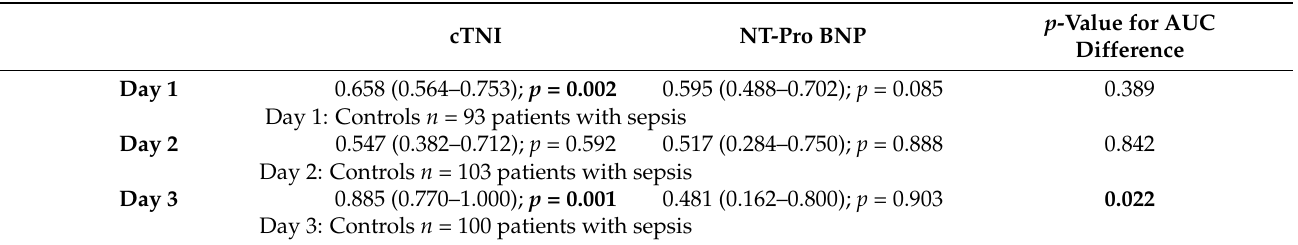
Table 4. C-statistic for biomarkers at days 1, 2 and 3 to discriminate between patients with sepsis and septic shock.